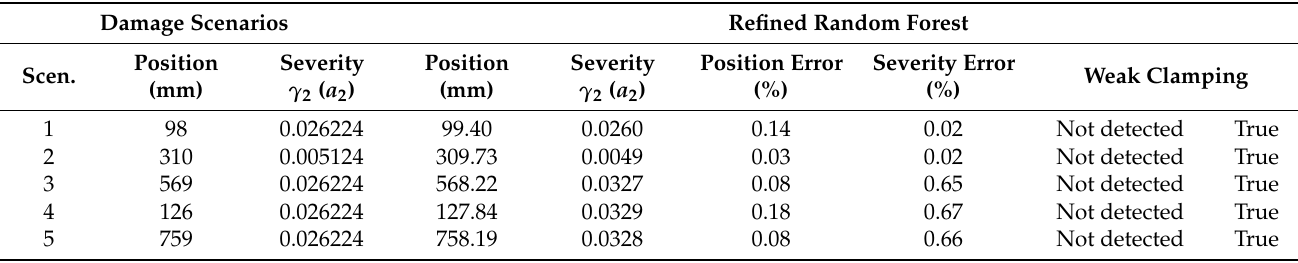
Table 14. Obtained results using the refined Random Forest